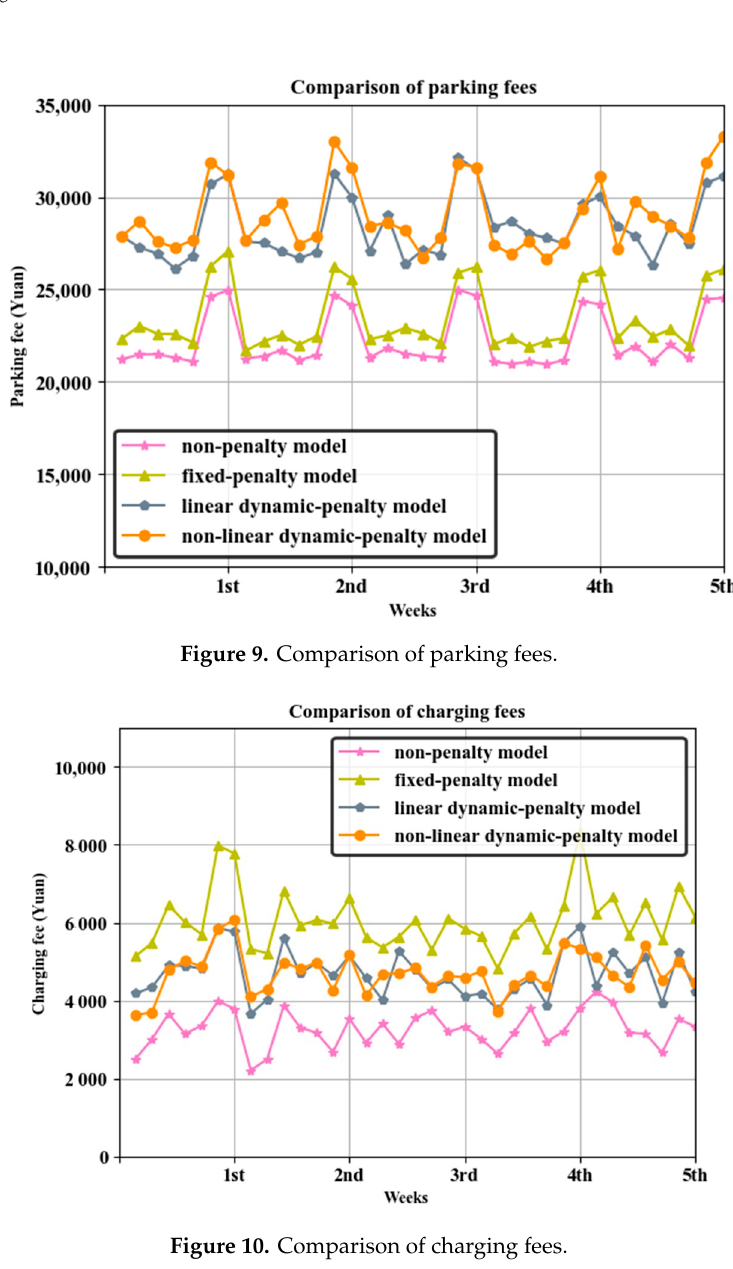
Figure 9. Comparison of parking fees.